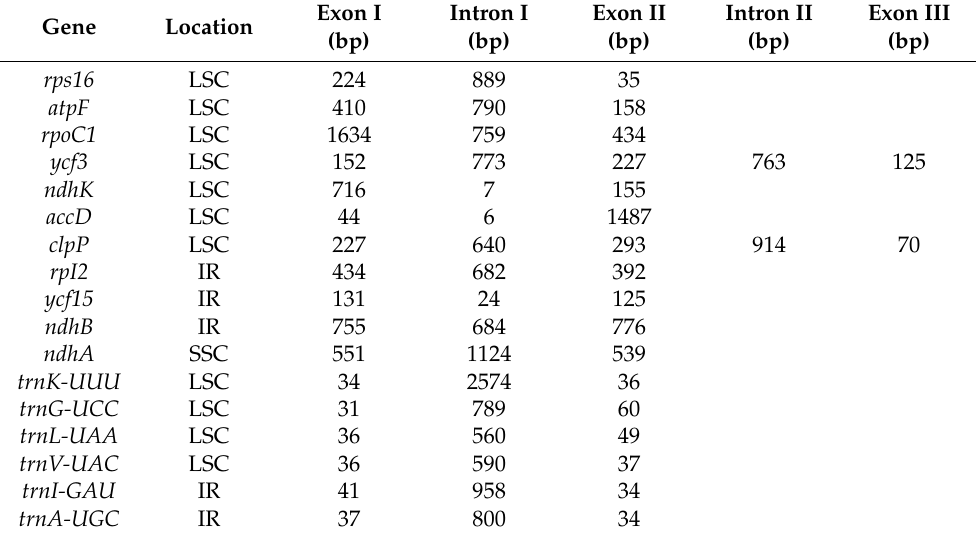
Table 3. The introns in the genes of the A. fruticosum plastome. Gene Location